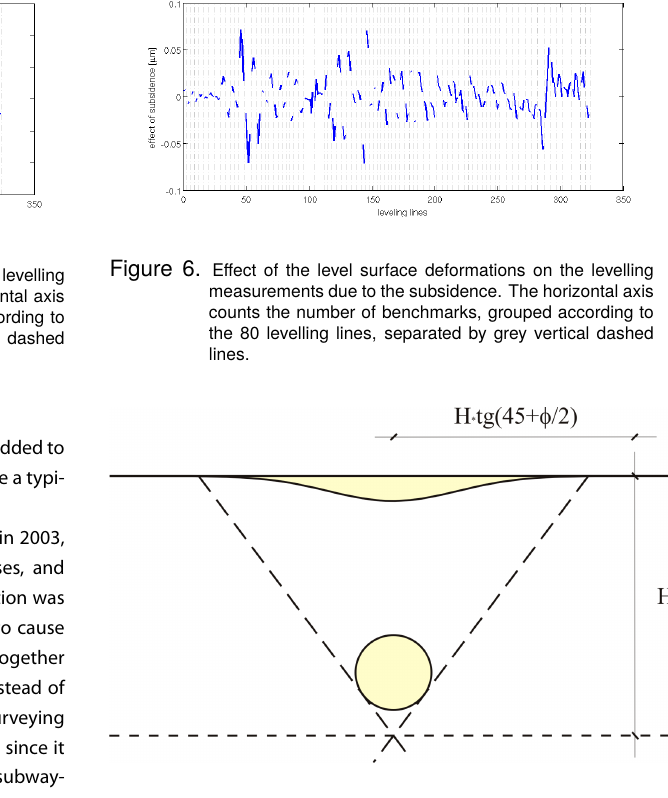
Figure 7. The relation between the depth of tunnelling and the exten- sion of the subsided area. tunnelling on the levelling (c.f. Fig. 5) is in the (cid:22) m order. The